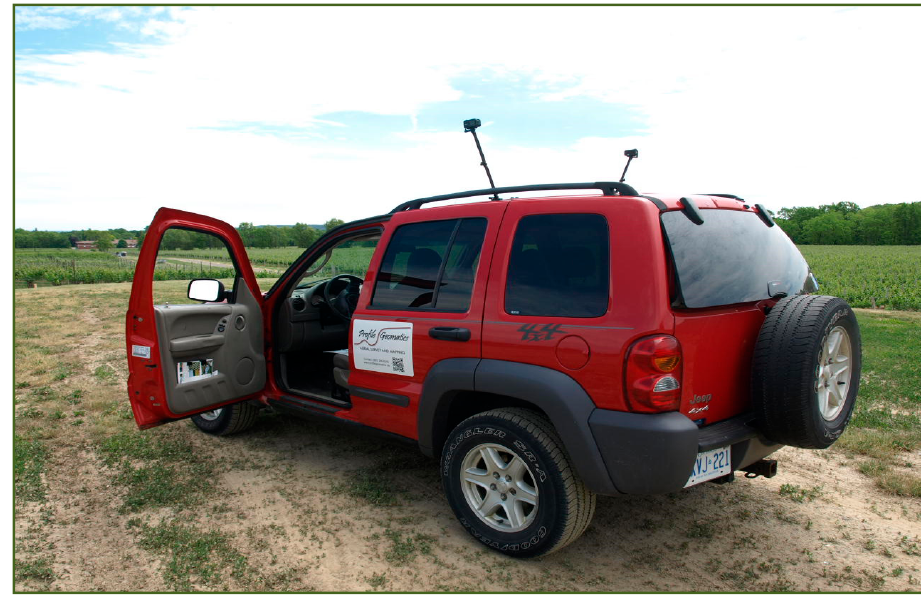
Figure 2. Roadside survey vehicle camera system with roof-top camera mounts.